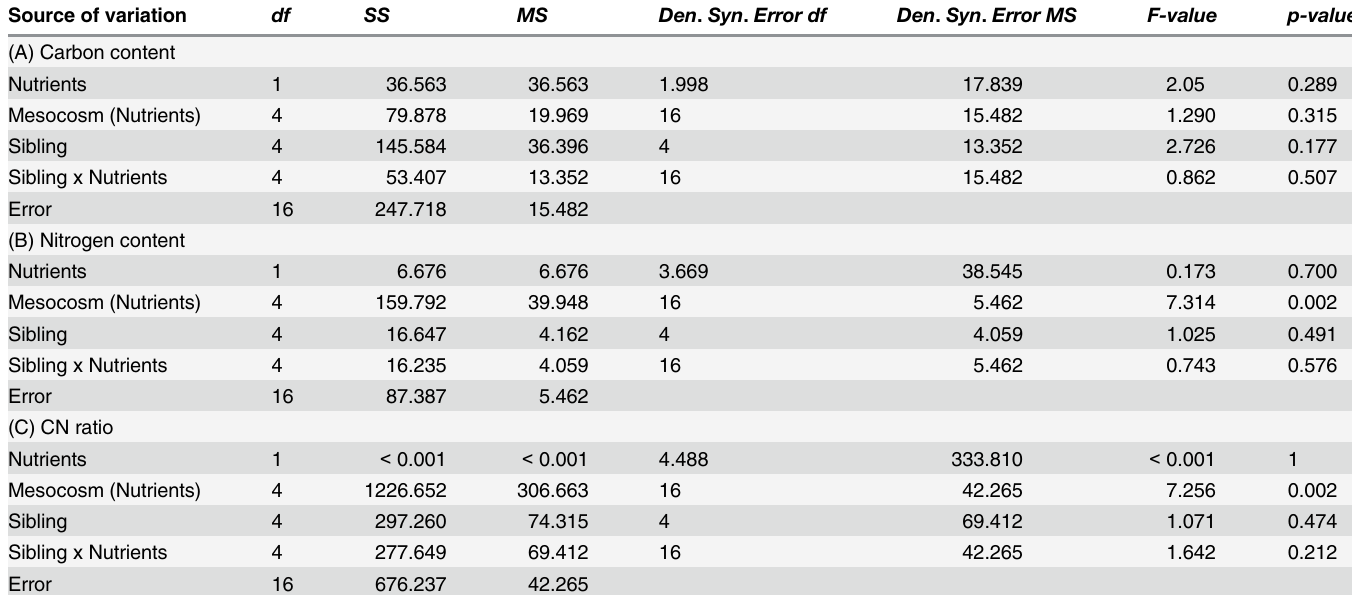
Table 3. Nutrient effect on carbon and nitrogen content (% DW) and on the CN ratio. Split-plot ANOVA with the fixed factor ‘ Nutrient ’ and the random factors ‘ Mesocosm ’ and ‘ Sibling group ’ . Effects of the nutrient treatment were analysed for (A) the carbon content (% DW), (B) the nitrogen content (% DW) and (C) the CN ratio. Df: degrees of freedom, SS: sums of squares and MS: mean squares. ‘ Den. Syn. Error df ’ and ‘ Den. Syn. Error MS ’ describe the denomi- nator synthesis of degrees of freedom and mean squares,